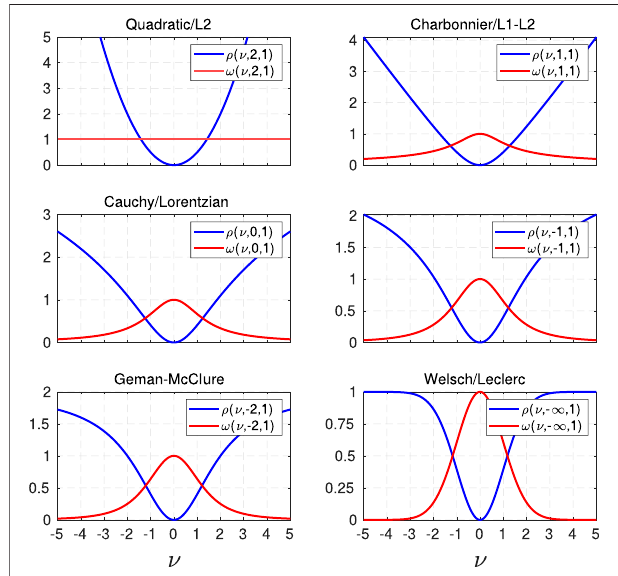
FIGURE 2 | The adaptive loss kernel and its weight for various values of the shape parameter α . When α is 2, the adaptive loss kernel forms the standardquadratic/L2functionwhichisnotrobusttooutliers.For α equalto1, 0, -2 and − ∞ , the adaptive loss kernel can form the robust functions known as Charbonnier/L1-L2, Cauchy/Lorentzian, Geman-McClare and Welsh/Leclerc,